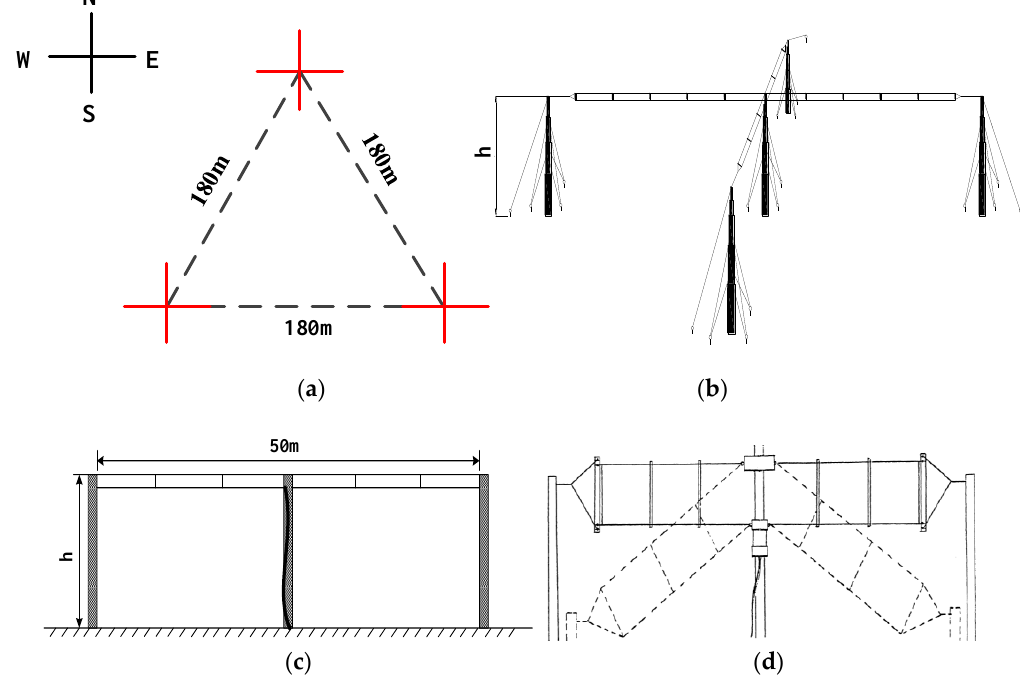
Figure 9. The antenna erection form: ( a ) The array structure, with a positive triangle structure; ( b ) The erection form of each vertex. The two antennas are erected in an orthogonal way; ( c ) The schematic erection form of a single receiving antenna with the feed point in the center. Due to the influence of gravity, the antenna cannot be straightened completely. The distance between the two poles is 50 m; ( d ) The structure image of the Barker & Williamson Broadband Folded Dipole Antennas. The dotted line ind icates the erection scheme type of the inverted “V” , which is not adopted in this paper.